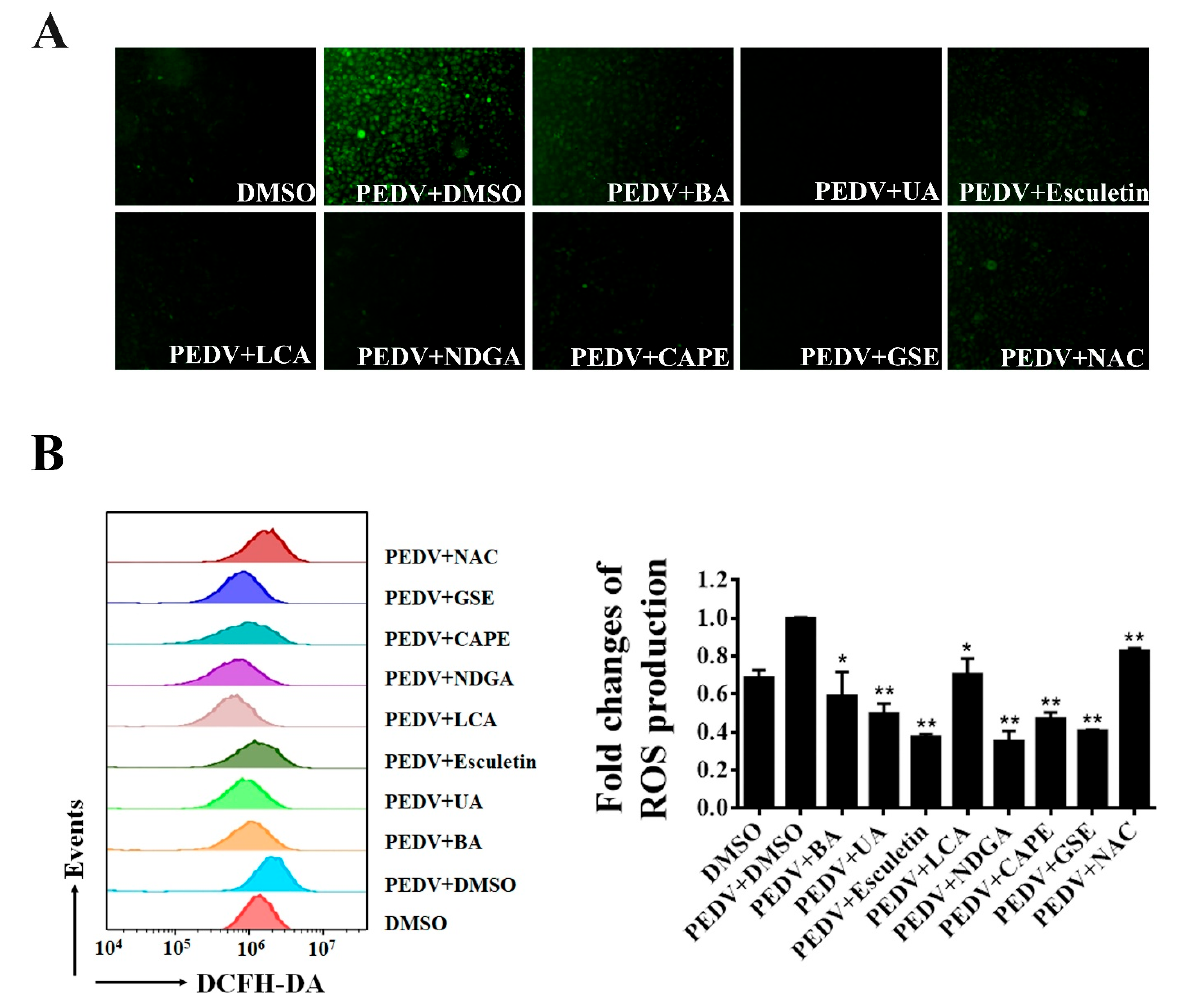
Figure 6. The inhibition of PEDV-induced ROS by identified antioxidants. Vero cells were treated with each antioxidant at the concentration of 10 µ M, and then infected with wild-type PEDV at a MOI of 0.01. NAC (50 µ M) and DMSO were used as the positive and negative controls. At 16 h post-infection, the cells were stained with DCFH-DA and intracellular ROS generation was examined by a fluorescence microscope ( A ) or flow cytometry ( B ). The relative ROS levels were calculated by the DCFH-DA fluorescence intensity in PEDV-infected cells. Mean ± SDs from three independent experiments are displayed. * p < 0.05 and ** p < 0.01 vs. PEDV-infected cells treated with DMSO (unpaired Student’s t -test).